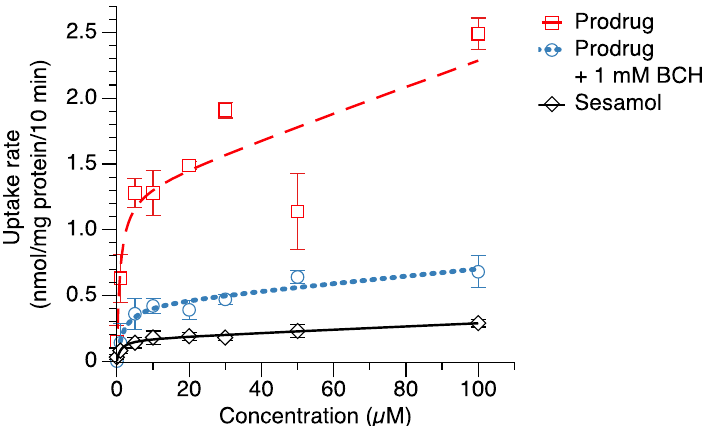
Figure 3. Cellular uptake of sesamol ( ◇ ) , sesamol prodrug ( ☐ ) , and sesamol prodrug co - incubated with 1 mM BCH (○) in melanoma SK - MEL - 2 cells . The uptake rates were fitted with a nonlinear least-squares kinetics model and are represented as dash line (–), dot line ( ··· ), and straight line ( − ) for prodrug, prodrug with 1 mM BCH, and sesamol uptakes, respectively. Data are expressed as mean ± standard deviation of three replicates. Table 2. Uptake kinetic values of sesamol and sesamol prodrug in melanoma cells. Compound